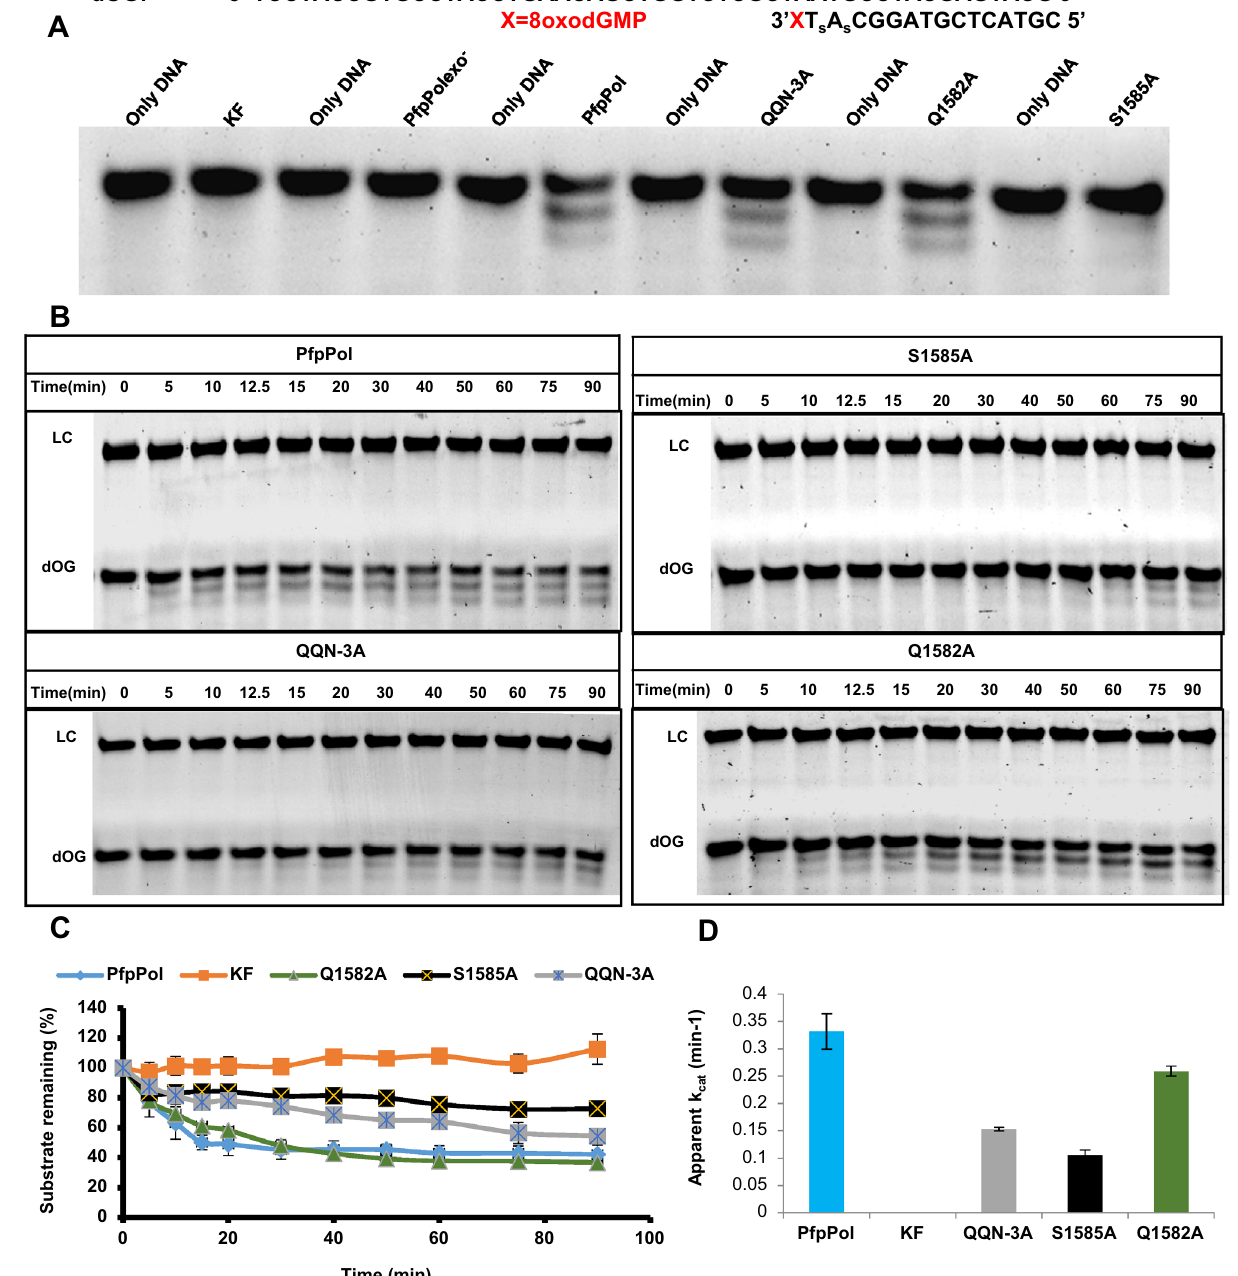
Figure 4. Proofreading activity of PfpPol and the mutant enzymes on dOG DNA substrate. ( A ) 10 nM of protein was incubated with 100 nM DNA (dOG) substrate without dNTPs for 1 h at 37 °C. PfpPol is able to remove 8oxodGMP from the primer end, in comparison the KF shows no excision activity. The PfpPolexo − enzyme was used as a negative control. ( B ) Denaturing PAGE gels showing excision of 8oxodGMP from 0 to 90 min. LC and dOG denote loading control and the DNA substrate with 8oxodGMP at the 3 ′ end, respectively. Protein to DNA ratio was maintained at 1:10. S1585A and QQN-3A show reduction in their exonuclease activity as compared to PfpPol. ( C ) Percentage of the substrate (dOG) remaining plotted against time of incubation (0 ′ to 90 ′ ) for PfpPol, KF, QQN-3A, Q1582A and S1585A.The error bars denote standard deviation values (n =